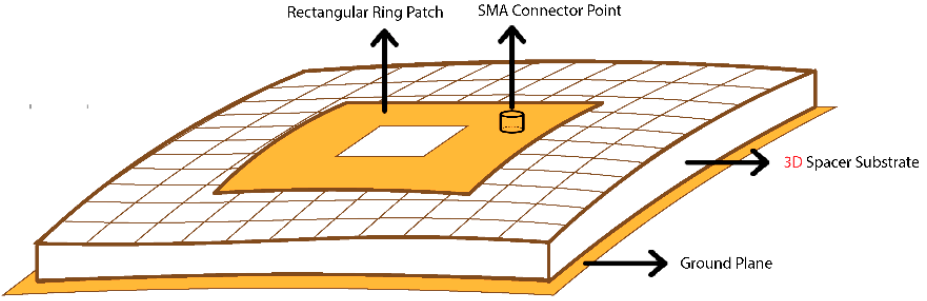
Figure 1. Microstrip rectangular ring patch antenna.